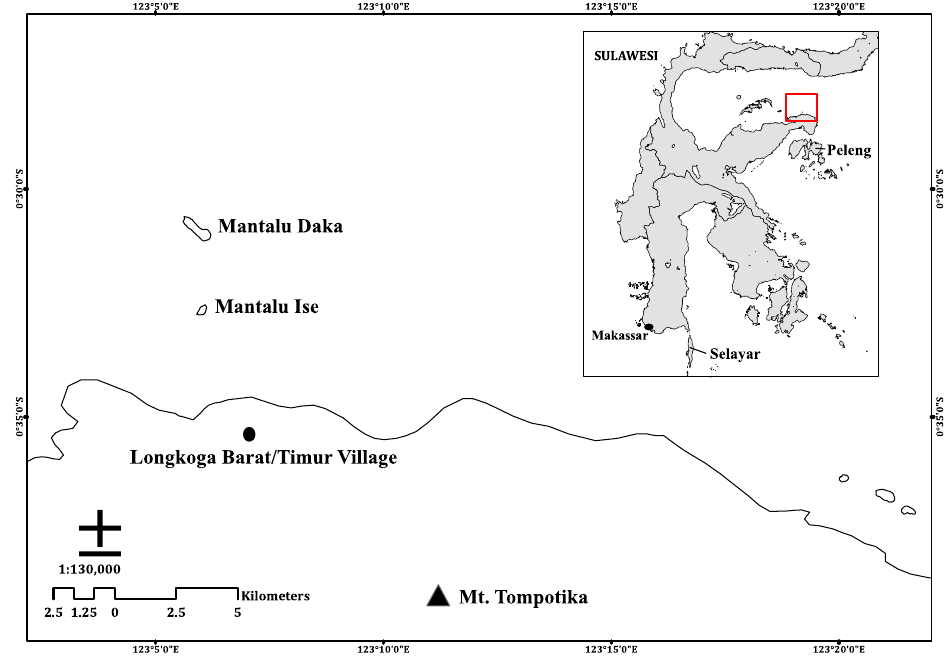
Figure 1. Study site in Mantalu Daka, Bualemo, Central Sulawesi.